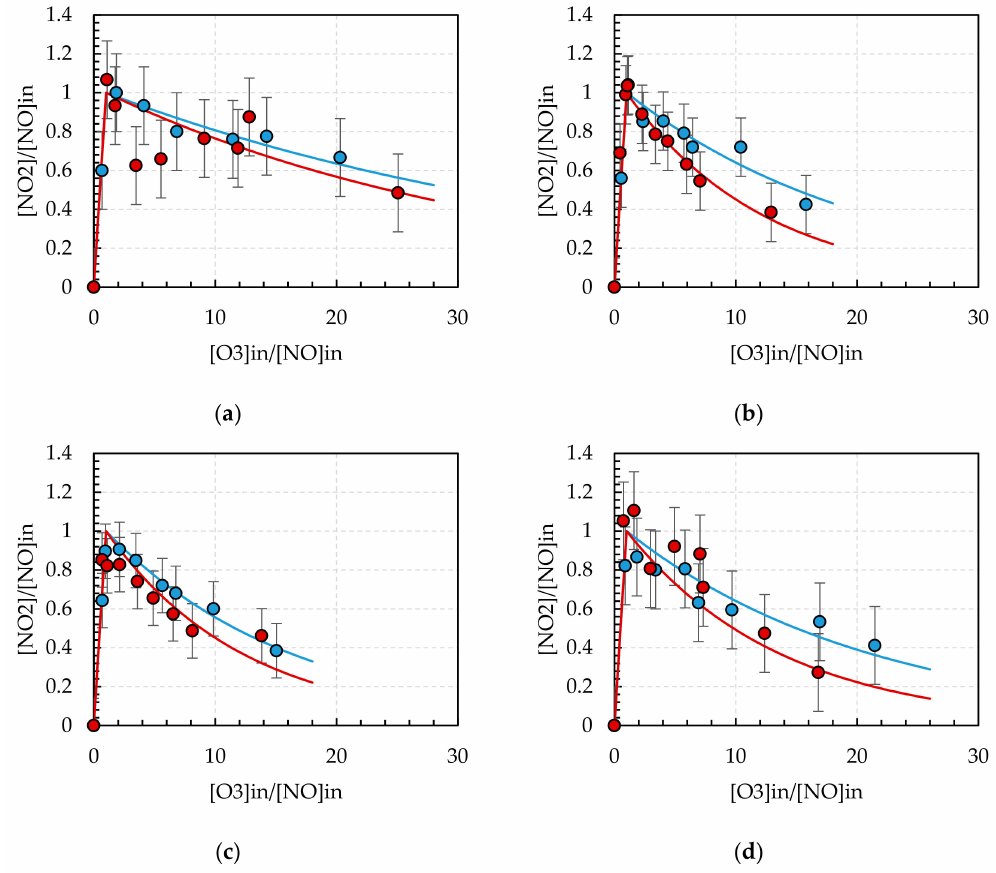
Figure7. RelativeconcentrationofNO 2 , [NO 2 ] / [NO] in , asafunctionofrelativeinletozoneconcentration, [O 3 ] in / [NO] in, during the ozone treatment in presence (red circles) and absence (blue circles) of the catalyst at ER ( a ) 0.8; ( b ) 1.0; ( c ) 1.2; ( d ) 1.4 value (the lines show theoretical values calculated according to the formula